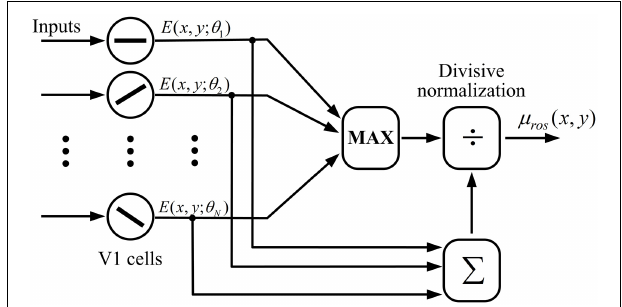
FIGURE 4 | Computation of ROS with a possible neural network of divisive normalization. A winner-take-all (or MAX) operation is used to select the cell with the maximum CRF response across all N θ cells with different preferred orientations within a hypercolumn, which is further divided by the sum of CRF responses of these